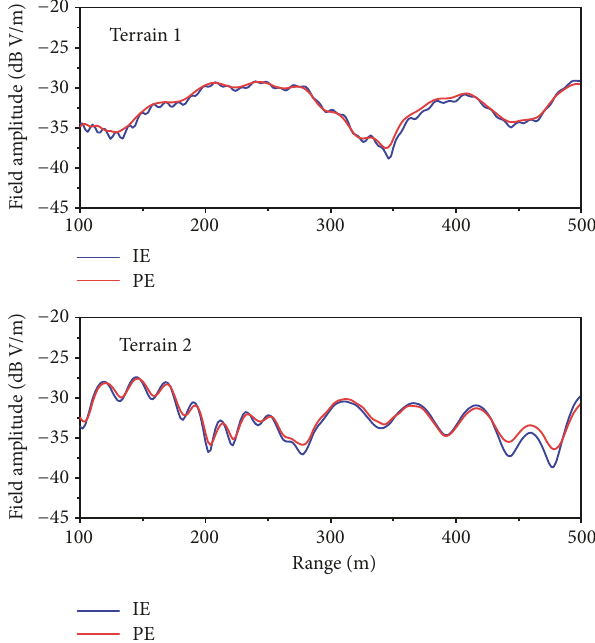
Figure 11: Electric field at a receiving distance of 3 km.